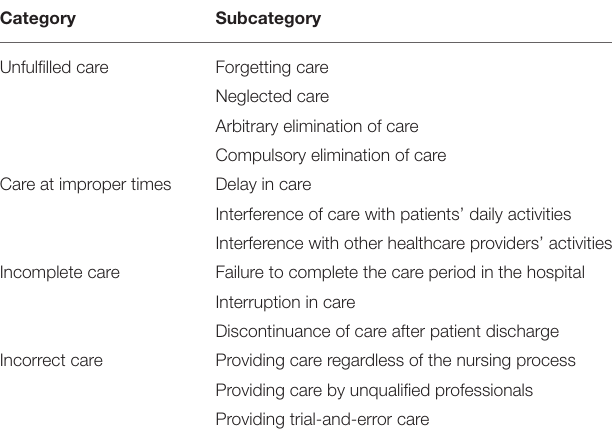
TABLE 2 | Summary of Elo and Kyngas qualitative method. Preparation Analysis unit selection